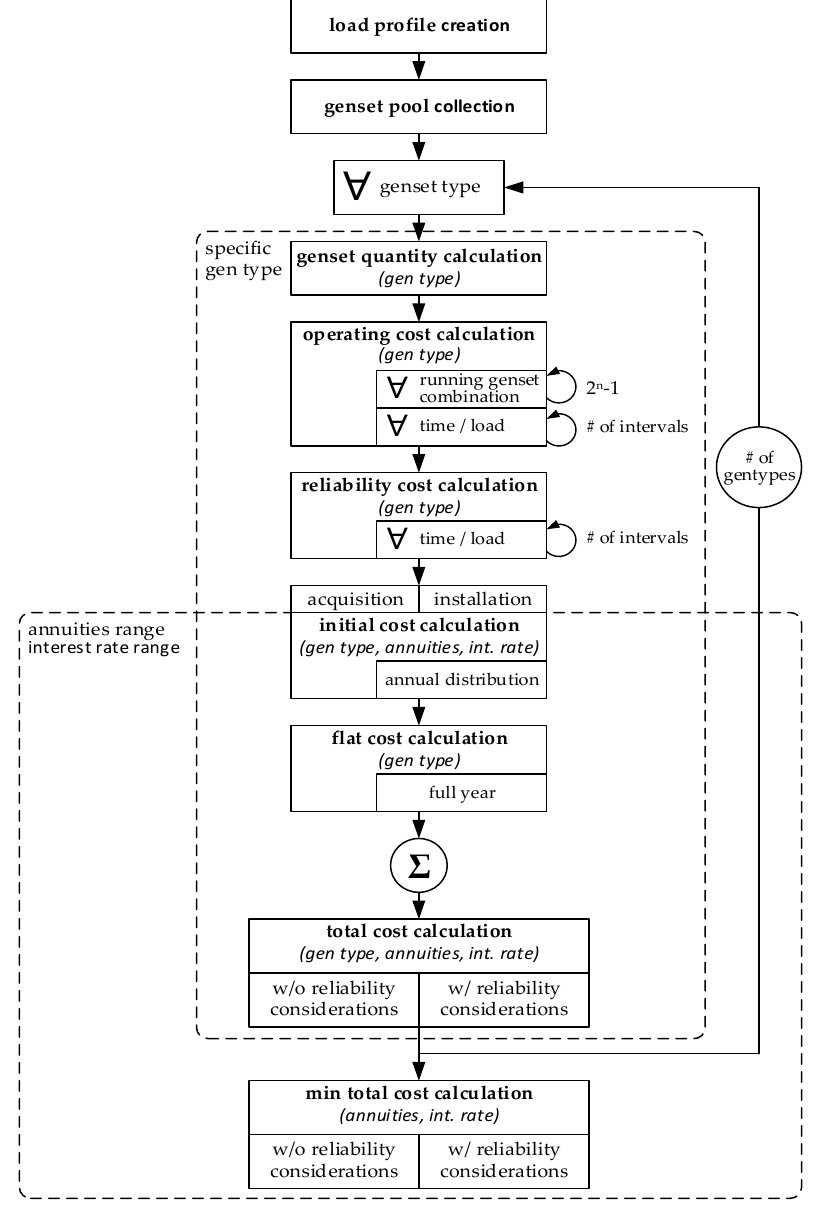
Figure 2. Calculation process overview.